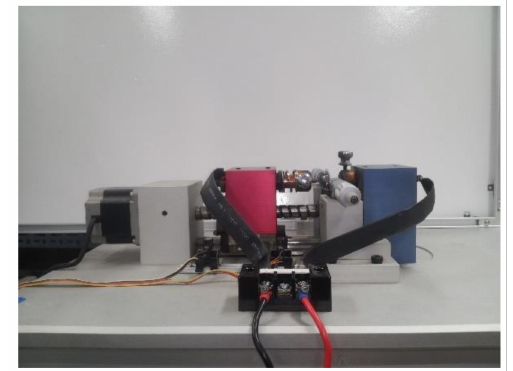
Figure 2. Photo of DC switch automatic test